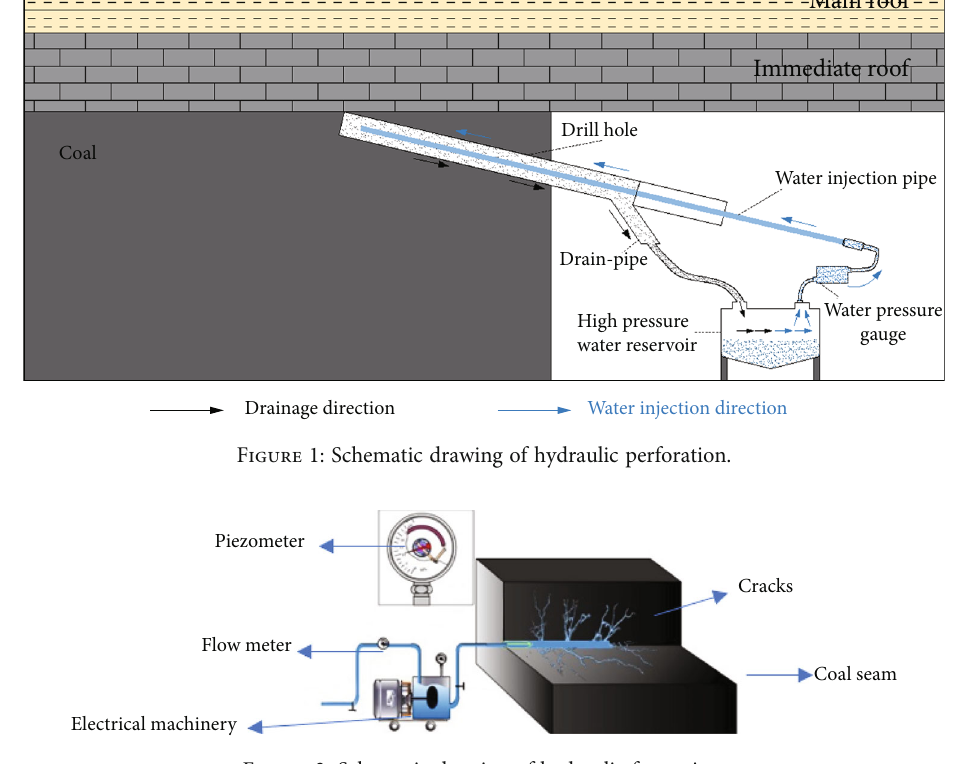
Figure 2: Schematic drawing of hydraulic